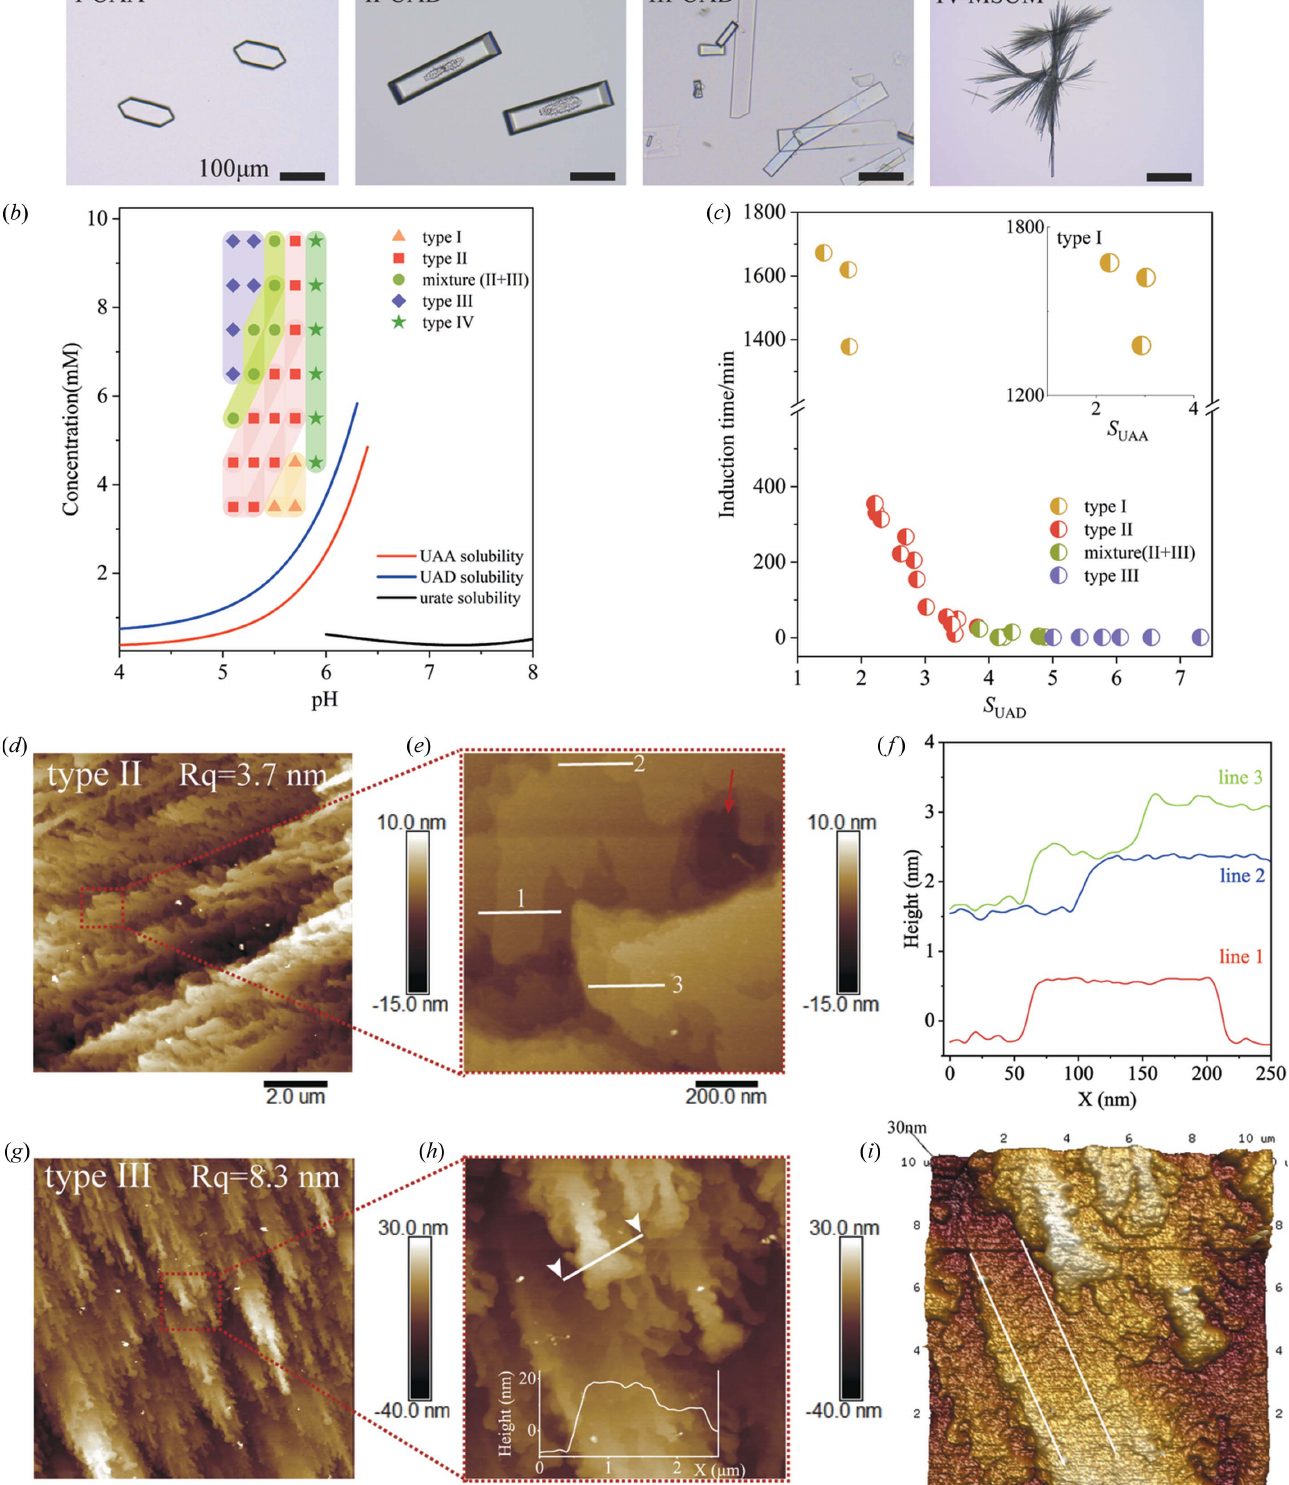
Figure 5 Crystallization regime of core-shell crystals. ( a ) Four types of urate crystals formed under various crystallization conditions. ( b ) Crystallization map of four types of urate crystals. The spots of different colors represent different crystal types, the shadows with corresponding colors are interpolated to guide the eye. ( c ) Induction time distribution for crystallization of different types of crystals as a function of solution super-saturation (relative to the UAD phase). Inset represents the induction time distribution for a type-I crystal plotted as super-saturation relative to the UAA phase. ( d ) and ( e ) Topology of the basal (001) surface of the type-II crystal and ( f ) step height profiles marked by white lines in ( e ). ( g ) and ( h ) Topology of the basal (001) surface of the type-III crystal and ( i ) 3D view of the (001) Li, Tang and Gong (cid:2) Shape-preserved pathway of a core-shell phase transition IUCrJ (2023). 10 , 38–51